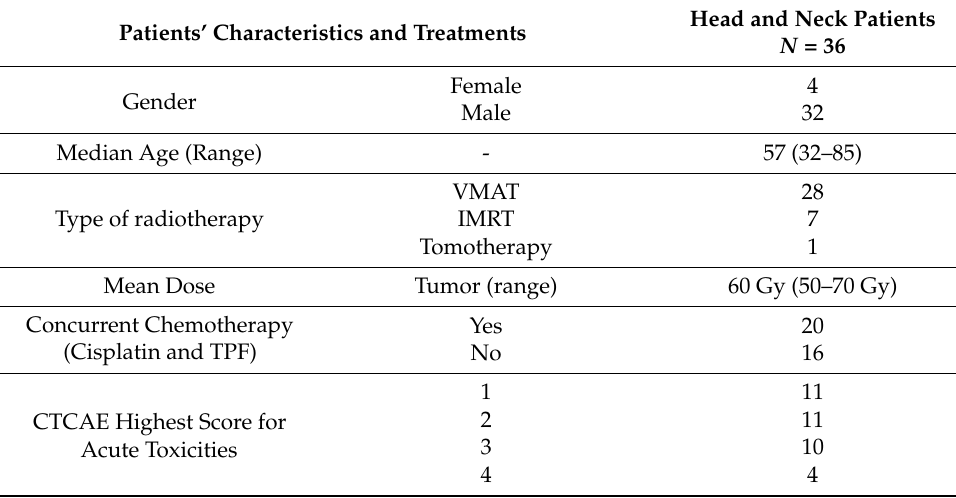
Table 2. Validation cohort: 36 patients’ characteristics and